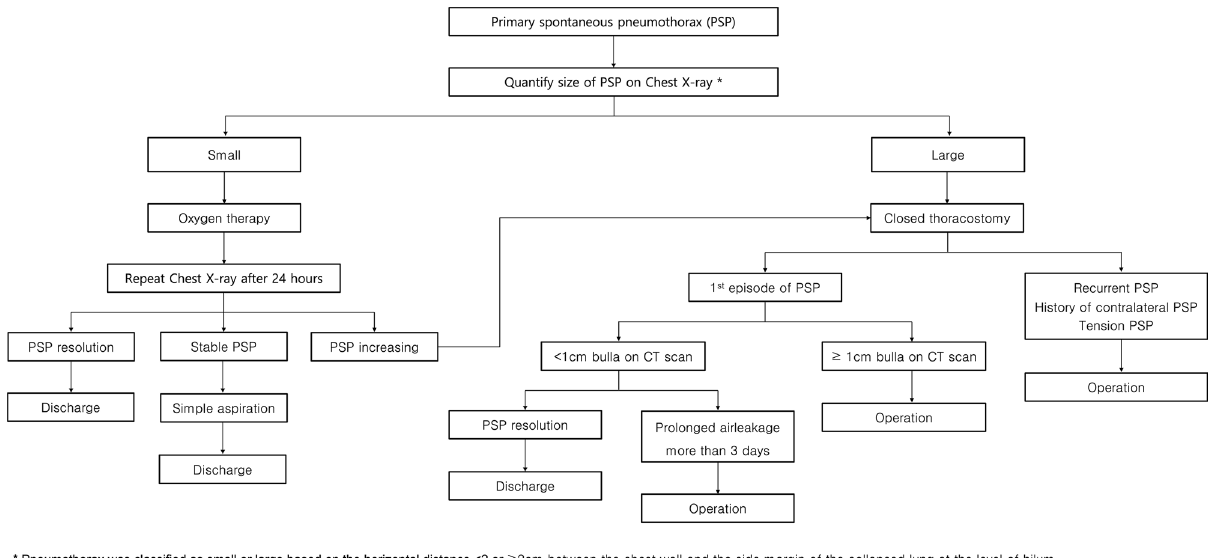
Figure 1. Treatment algorithm of primary spontaneous